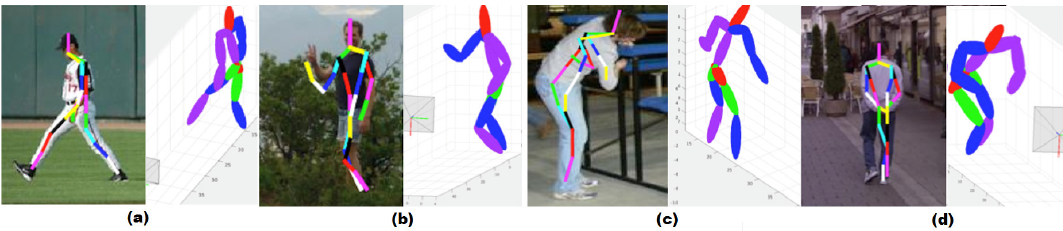
Figure 6. Typical examples for successful and failed three-dimensional pose reconstruction. ( a , b ) Two positive results on reconstruction; ( c , d ) two typical negative results on reconstruction.